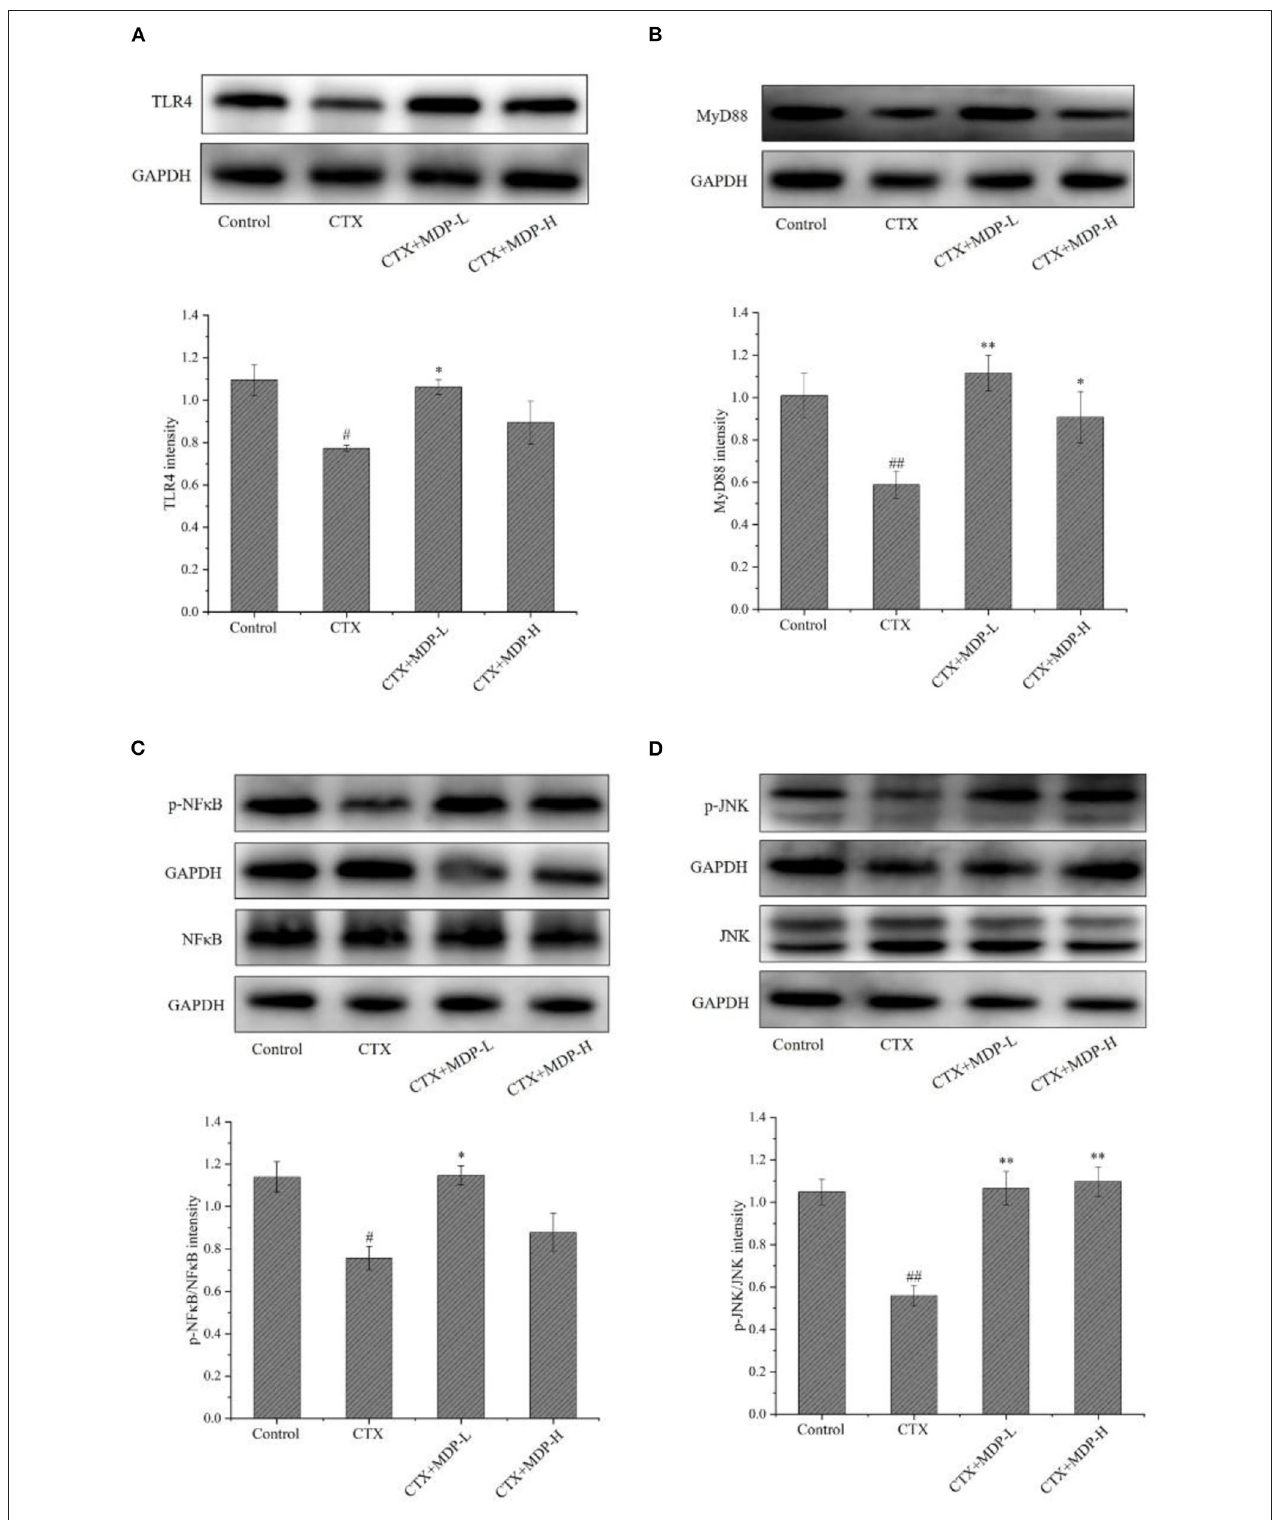
FIGURE 11 | Effect of MDP on the TLR4-MyD88 pathways in vivo . (A) The protein expressions of TLR4. (B) The protein expressions of MyD88. (C) The protein expressions of p-NF κ B. (D) The protein expressions of p-JNK. Values are given as means 0.01 vs. CTX